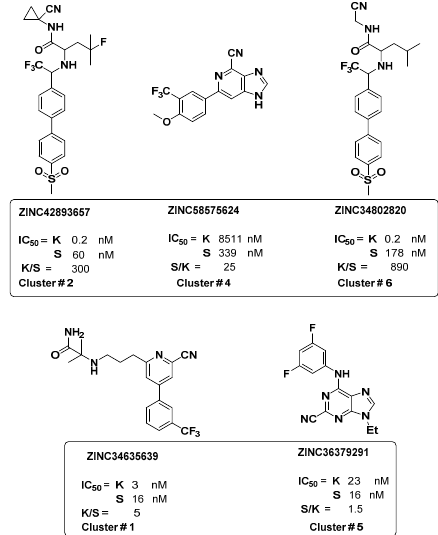
Figure 8. New cathepsin set. The figure shows retrieved ZINC compounds predicted and taken from selective clusters. The IC 50 of these compounds and clusters are reported with corresponding calculated selectivity.